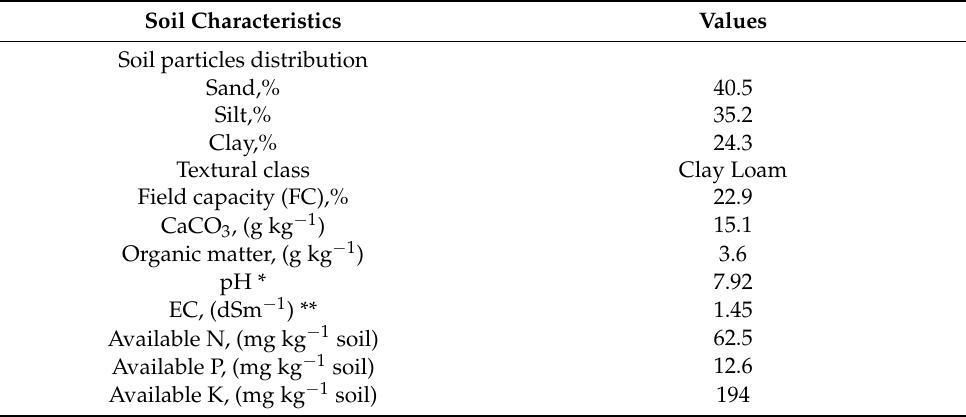
Table 1. Some physical and chemical properties of investigated